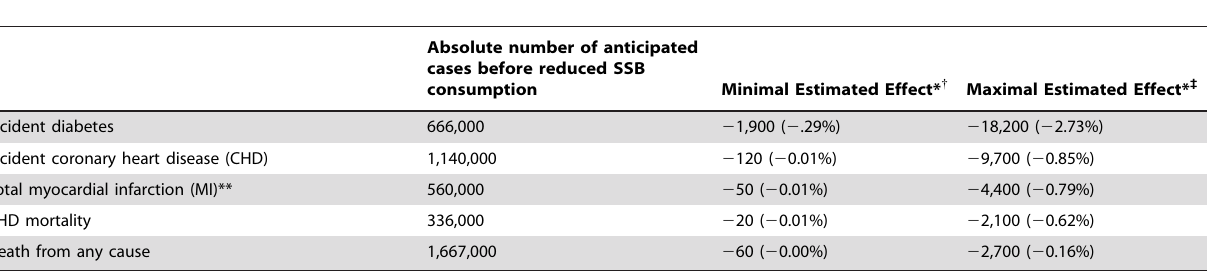
Table 3. Absolute number of events and deaths prevented from a 10% SSB consumption reduction under worst and best case scenarios from 2013–2022 in California (Percent change).